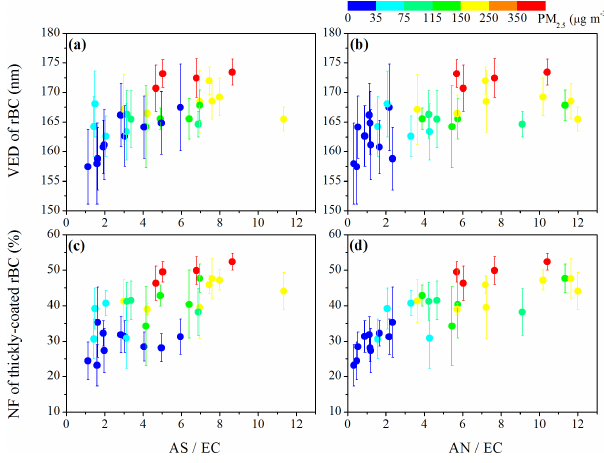
Figure 2. Variation in the average volume-equivalent diameters of rBC (VED rBC ) as a function of the mass ratios of (a) ammonium sulfate (AS) and (b) ammonium nitrite (AN) to elemental carbon (EC). The same apply for (c) and (d) , but for the number fraction of thickly coated rBC (NF coated ) . The vertical bar denotes one stan- dard deviation. The color scale represents the pollution levels de- fined as the PM 2 . 5 mass concentration according to the AQI stan- dard of MEP of